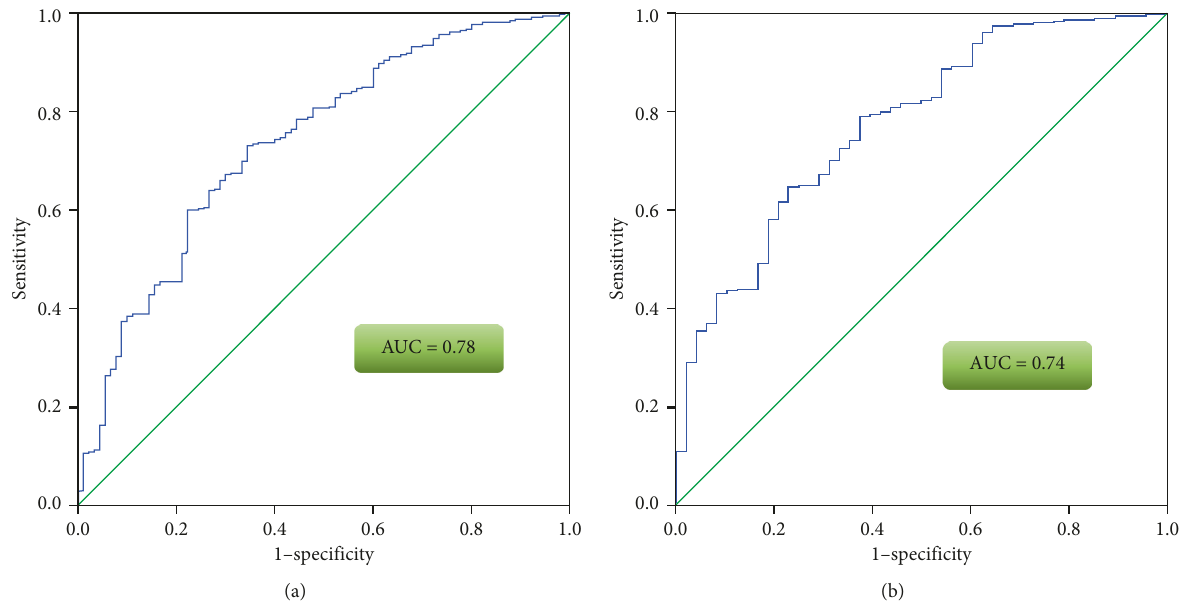
Figure 1: ROC curve of logistic regression models. (a) ICU discharge; (b) hospital